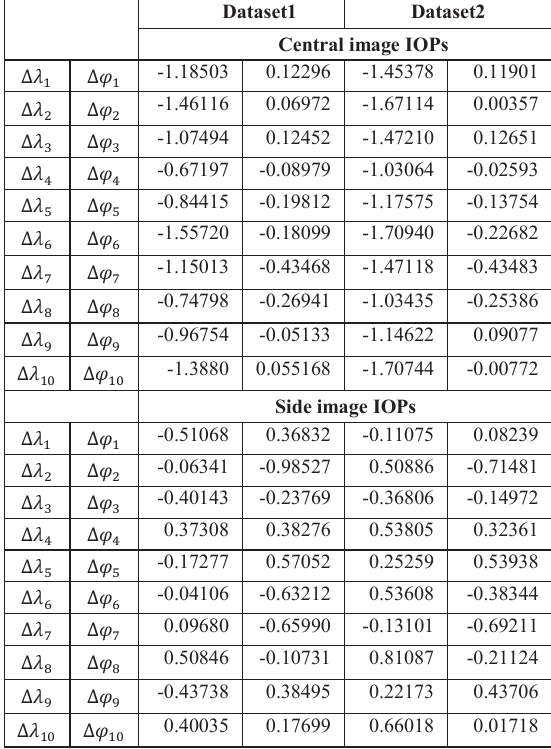
Table 2. Calibration parameters of side and central image, (cid:959)(cid:2019) and (cid:959)(cid:2030) in degree unit for two datasetes.